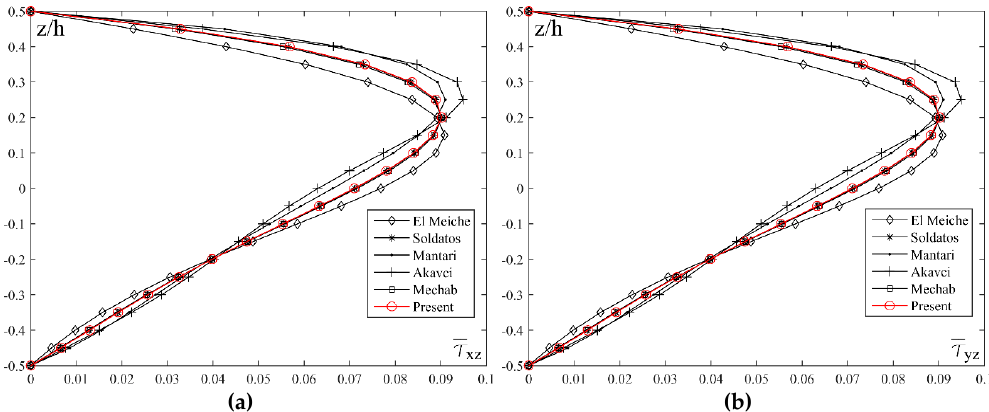
Figure 11. Distribution of the normalized values of the transverse shear stresses τ xz and τ yz across the thickness of the plate on elastic foundation for different shape functions: ( a ) a / h = 10, a / b = 1, p = 2, k 0 = 100, k 1 = 10; ( b ) a / h = 10, a / b = 1, p = 2, k 0 = 100, k 1 = 10.